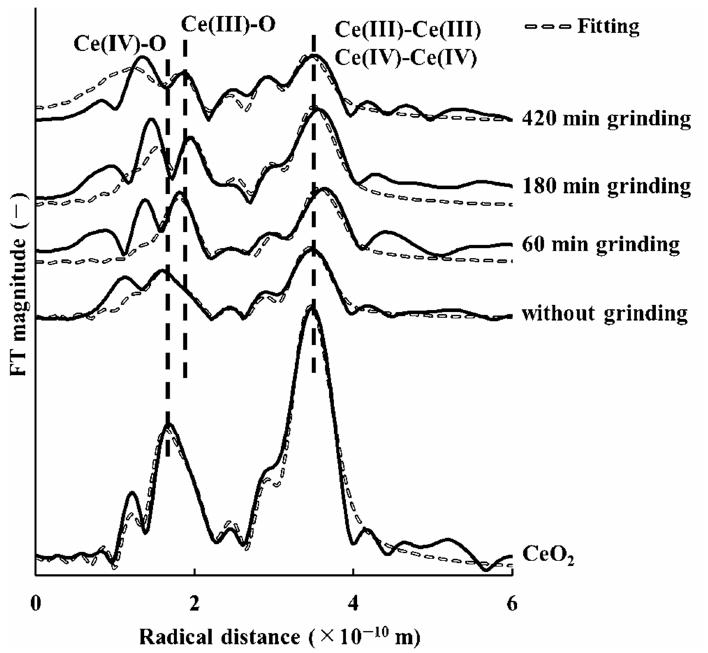
Figure 5. The radial distribution function of tetravalent cerium oxide, samples by grinding with microwave microwave irradiation.